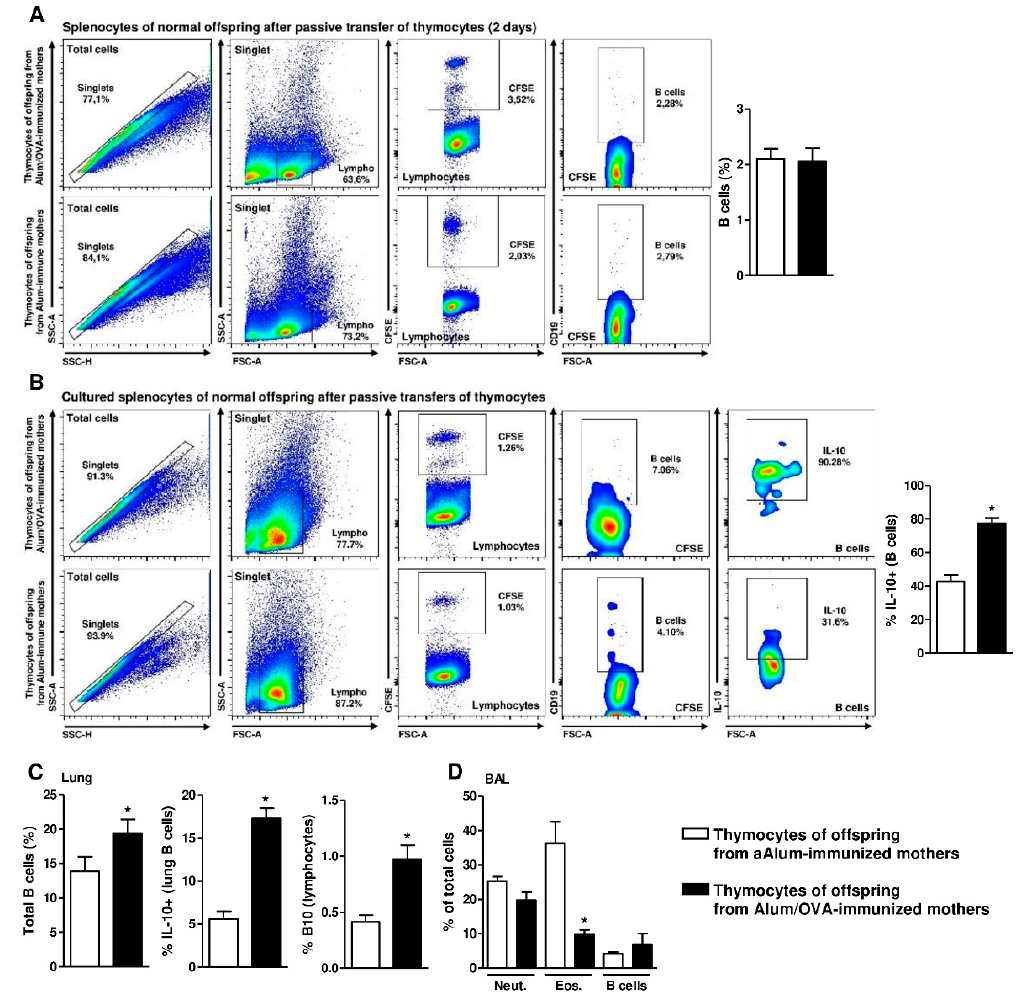
Figure 5. Identification and e ff ect of passive transfer of thymocytes on o ff spring allergic inflammation. Some o ff spring from nonimmune mothers were passively administered total thymocytes from 20-d.o. o ff spring of Alum-immunized or Alum / OVA-immunized mothers ( n = 8-9 pups in each group; pups were delivered from three mothers in each group). Twenty-d.o. o ff spring that passively received total CFSE-stained thymocytes were evaluated after 2 days, and the frequency of B cell transfer in the spleen is illustrated for both groups ( A ) Splenocytes from both groups were also cultivated without stimulus for 24 h, and the frequency of IL-10 production by transferred B cells is illustrated ( B ) Some groups of thymocyte-transferred mice were subjected to the allergic lung inflammation protocol, and the frequencies of B cells and IL-10-producing B cells were evaluated in lung tissue ( C ) BAL from the same groups was also evaluated, and the frequencies of neutrophils, eosinophils, and B cells are shown ( D ) Data are presented as the mean ± SEM. * p ≤ 0.05 compared with the Alum-immunized groups using Mann–Whitney U